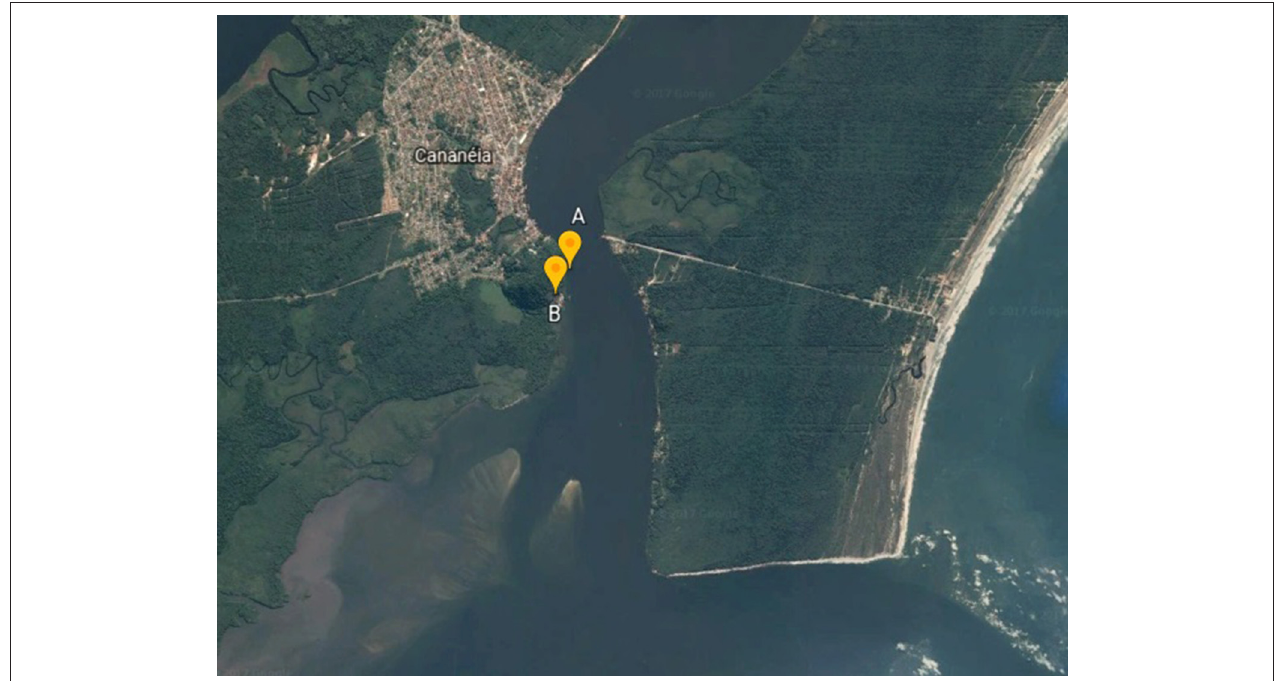
FIGURE 3 | Location of sampled points. (A) CAN-N-01, (B) outcrop of São Jõao hill, Cananeia region. São Paulo, Brazil.